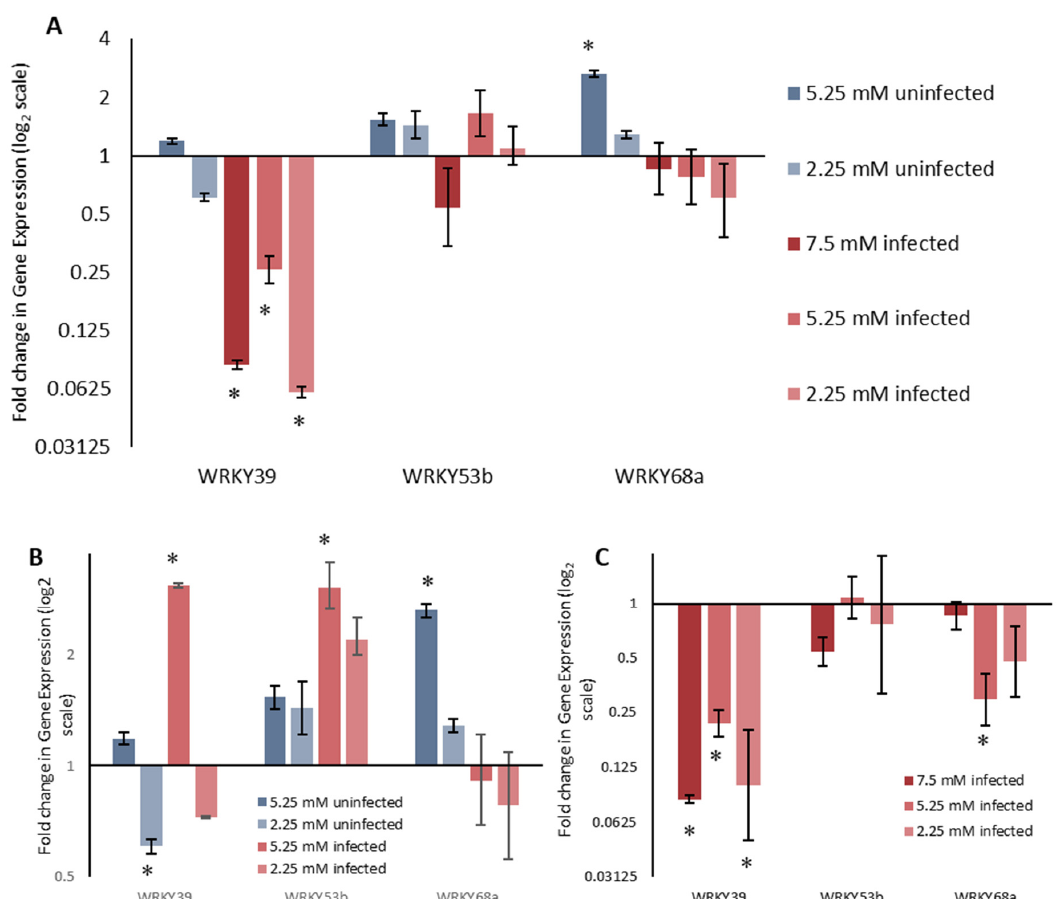
Figure 4. Expression of three WRKY transcription factors under combined stress assay of reduced nitrogen availability and biotrophic stage Septoria infection. ( A ) Fold change is displayed relative to plants grown under 7.5 mM nitrogen, which were not infected with Septoria. ( B ) Fold change is displayed relative to plants grown under 7.5 mM in the same infection state. ( C ) Di ff erential expression of three WRKYs caused by infection with Septoria when grown under di ff erent nitrogen treatments. Fold change is displayed relative to uninfected plants grown at the same nitrogen concentration. ALL ∆ C T values were analysed using ANOVA followed by Tukey post-hoc, n = 6. * p < 0.05 for di ff erence in ∆ C T value compared to reference condition .